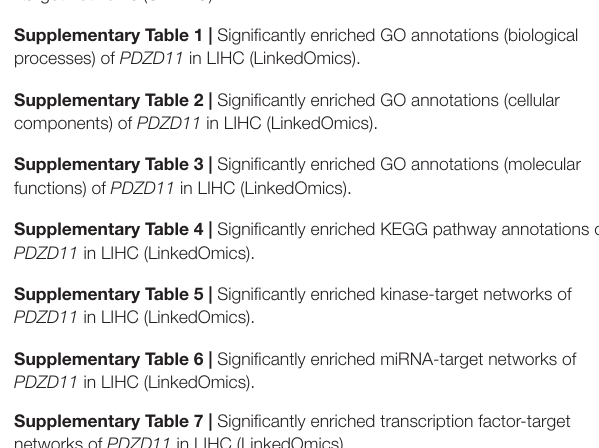
Supplementary Figure 2 | PPI network of MIR-505 (STRING).